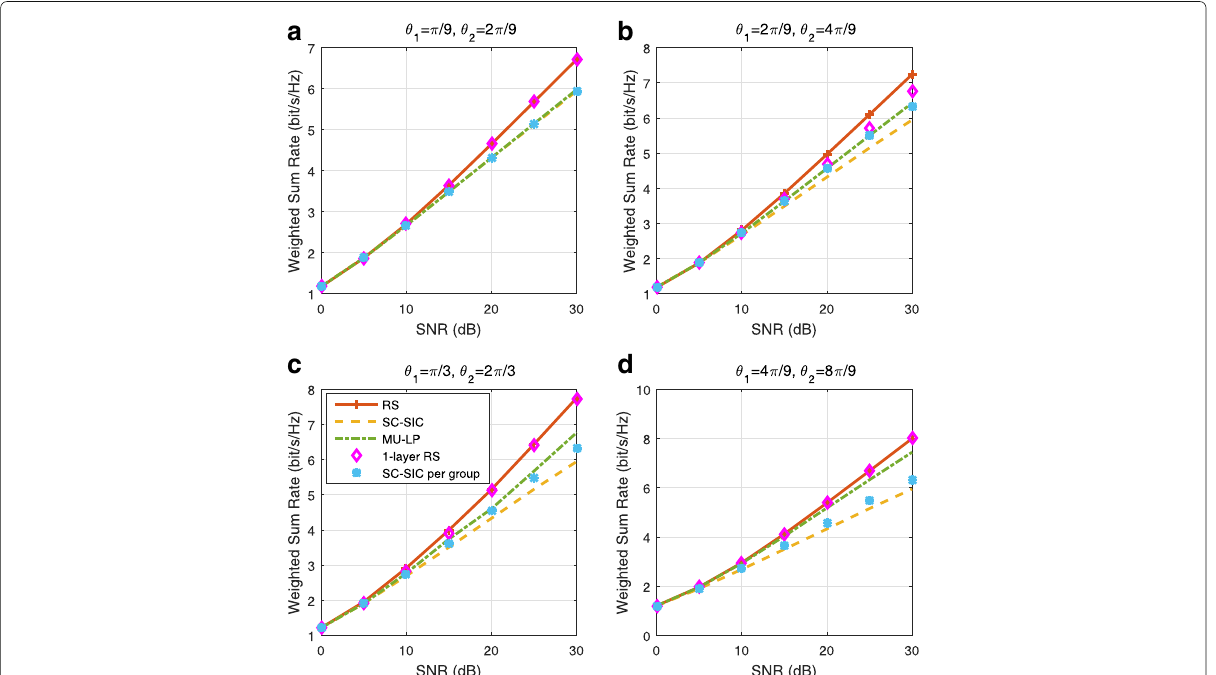
Fig. 46 Weighted sum rate versus SNR comparison of different strategies for underloaded three-user deployment with imperfect CSIT, γ 1 = γ 2 = 1,